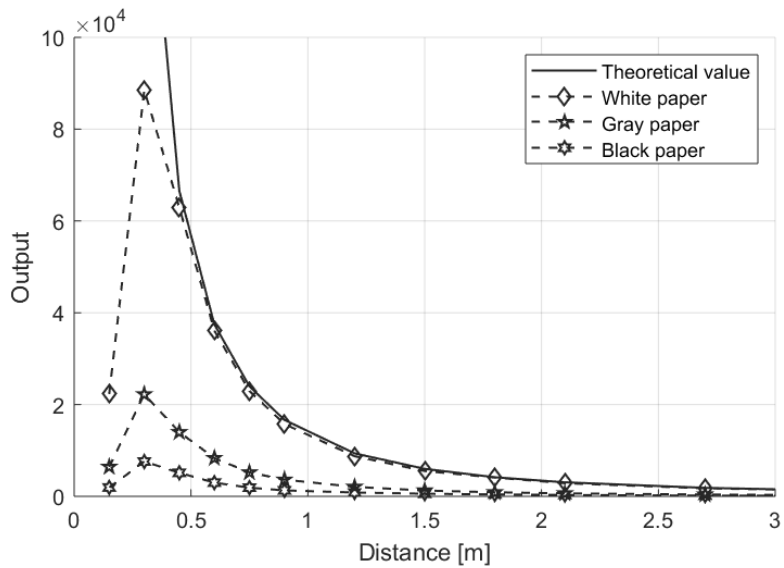
Figure 6. Measurement results as a function of target distance for white, gray, and black paper.